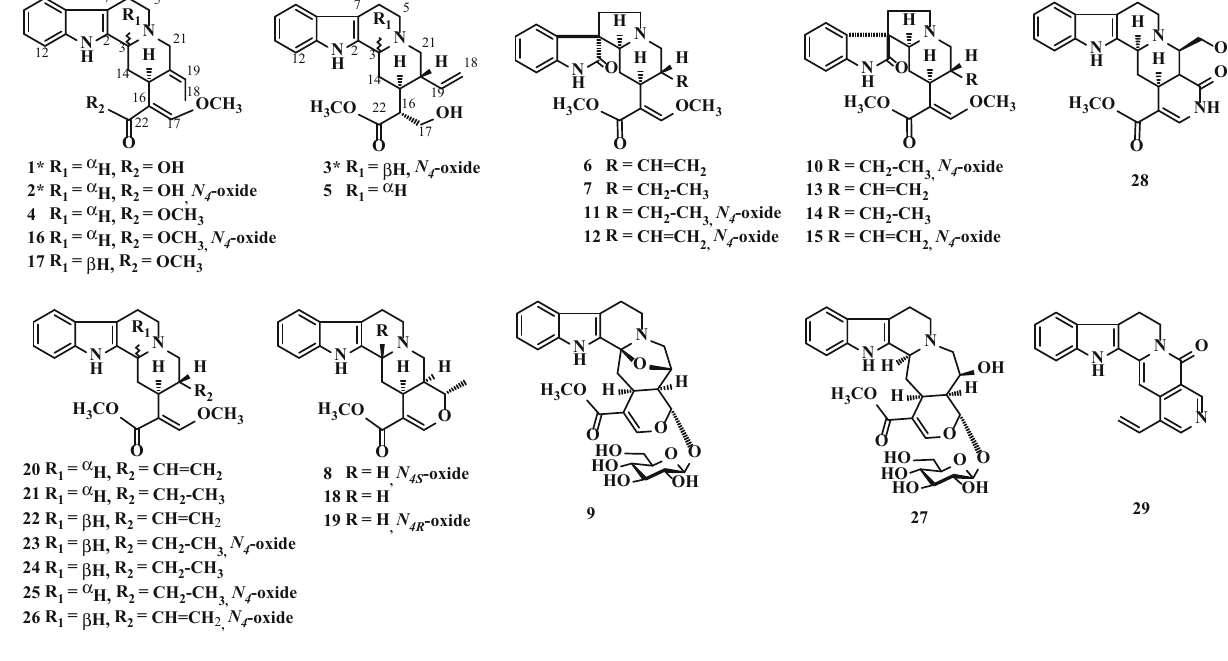
Fig. 1 Structures of compounds 1 –